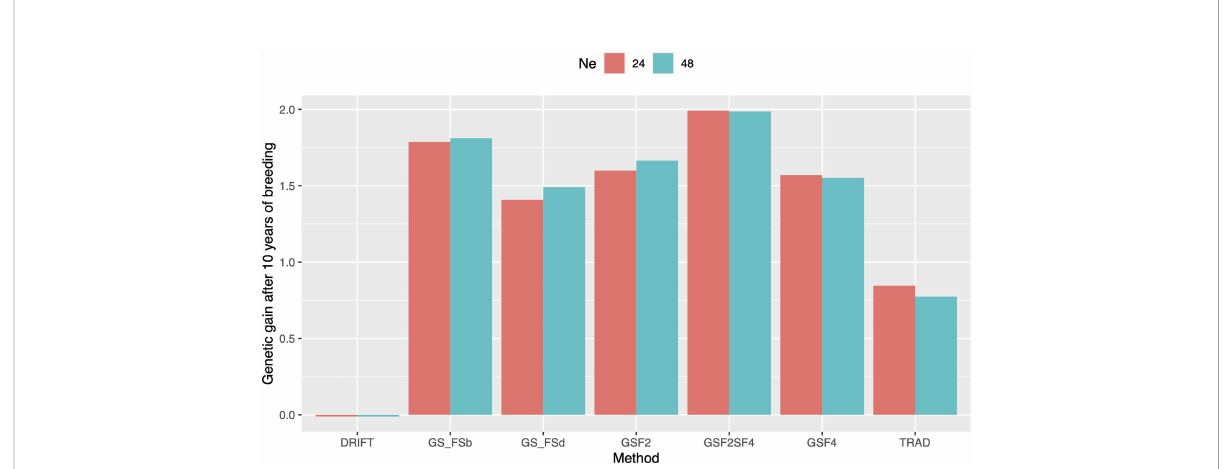
FIGURE 3 Genetic gains after ten years of breeding using different selection schemes and two sizes of parental lines (N=24 and N=48). Trad: traditional phenotypic selection; Drift: random selection; GS F2 : genomic selection performed in F2 stage; GS F2 S F4 : genomic selection performed in F2 stage and phenotypic selection performed in F4 stage; GS F4 : genomic selection performed in F4 stage; GS_FSb: genomic selection performed on F2 stage to select the two best individuals based on genomic estimated breeding values and crossed them to make a new recombination event; GS_FSd: genomic selection performed on F2 stage to select the two most divergent individuals and crossed them to make a new recombination